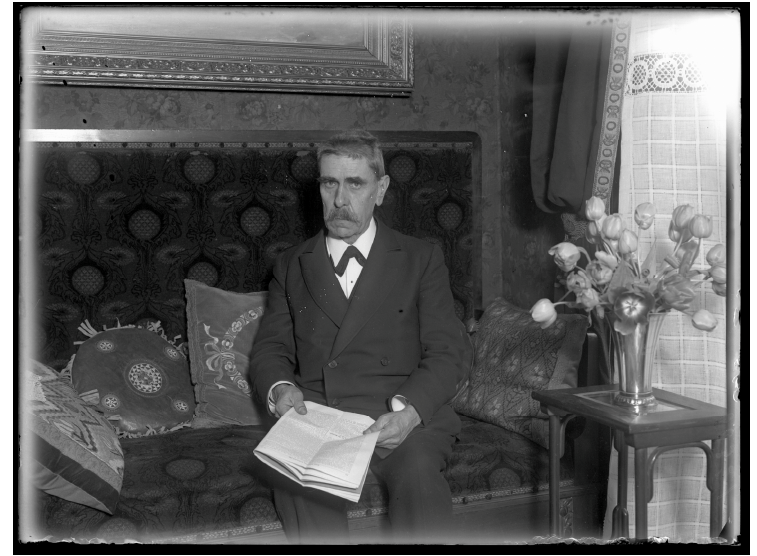
Figure 2. The Austrian neuropsychiatrist Julius Wagner-Jauregg (1857–1940) is the most outstanding